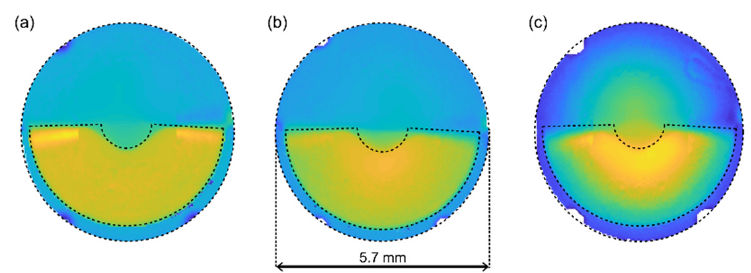
Figure 1. Power distribution in the Femtis Comfort lenses for 15 D ( a ), 20 D ( b ), and 30 D ( c ) base power. The blue and yellow areas indicate the labeled distance and near powers,